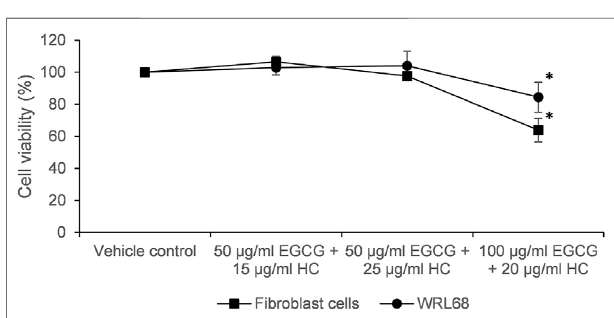
FIGURE 5 | Cytotoxicity of EGCG+HC on normal cells; foreskin fi broblastcellsandWRL68usingtheIC50ofcombinedEGCG+HCtreatment: 50 μ g/ml EGCG + 20 μ g/ml HC (dose for 1321N1), 100 μ g/ml EGCG + 25 μ g/ml HC (dose for SW1783) and 50 μ g/ml EGCG + 10 μ g/ml HC (dose for